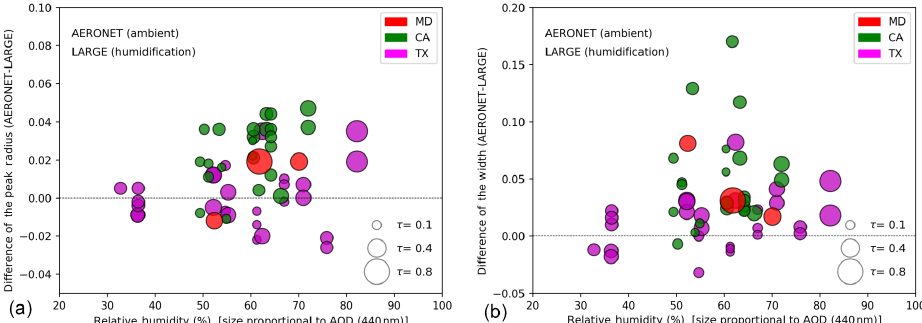
Figure 7. Differences in (a) r peak_conc and (b) width peak_conc between AERONET (ambient aerosol) and LARGE (with humidification adjustment) versus profile relative humidity. The marker size is proportional to the coincident aerosol optical depth (440nm) from AERONET.